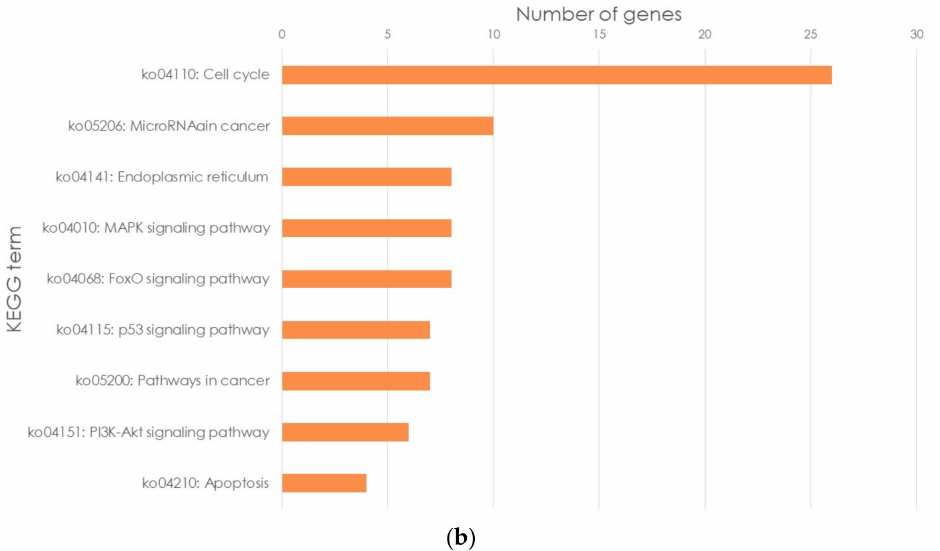
Figure 15. Bioinformatic analyses of the mechanism of curcumin in adrenocortical carcinoma: ( a ) The top ten enriched GO terms; ( b ) KEGG pathway analysis. (Figure 15 is taken from the work X. Huang [229]).